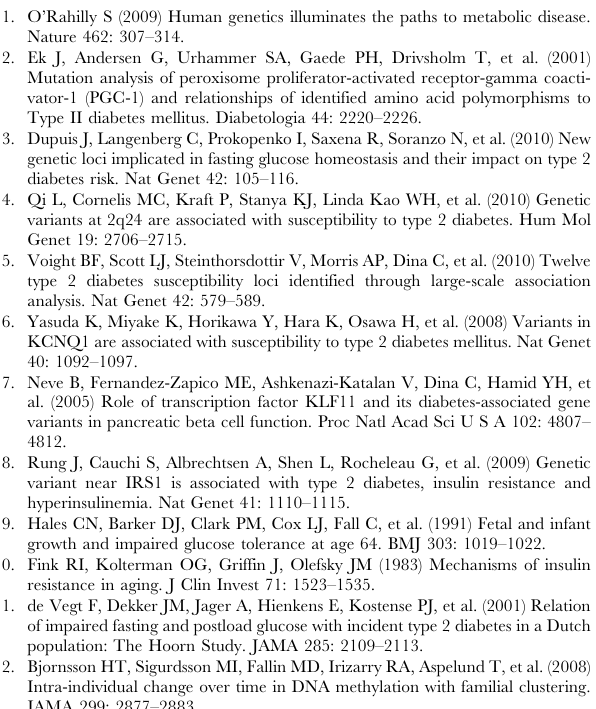
Figure S1 Validation of array data. The average DNA methylation in the gene promoter area surrounding the array site measured by bisulfite sequencing (BS) or bisulfite pyrosequencing (BPS) is indicated in type 2 diabetic (black bars) and non-diabetic (white bars) twins. Three twin pairs were included in the